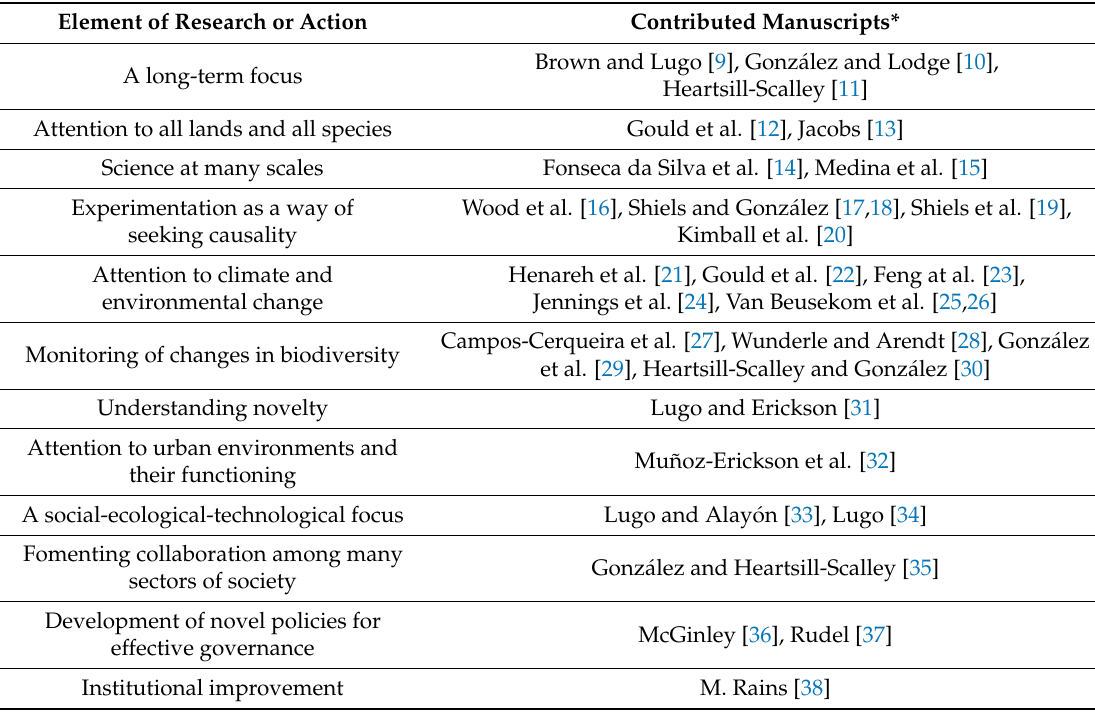
Table 1. List of research and conservation elements or activities that contribute to an effective forest research and development program relevant to addressing the uncertainties of the Anthropocene epoch, and example manuscripts in this Special Issue or in recent Special Issues produced by Institute